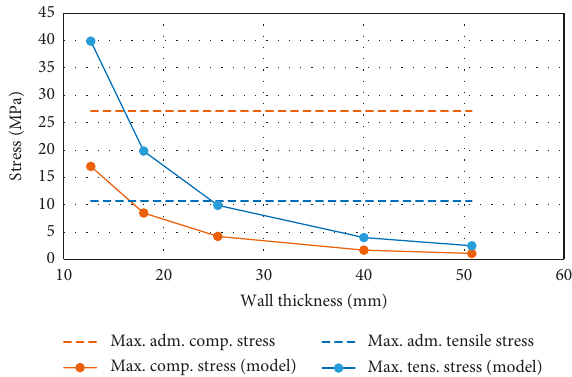
Figure 11: Comparison between maximum tensile and com- pressive stresses and maximum admissible tensile and compressive stresses for Utility Structure 2 as a function of the wall thickness (shell